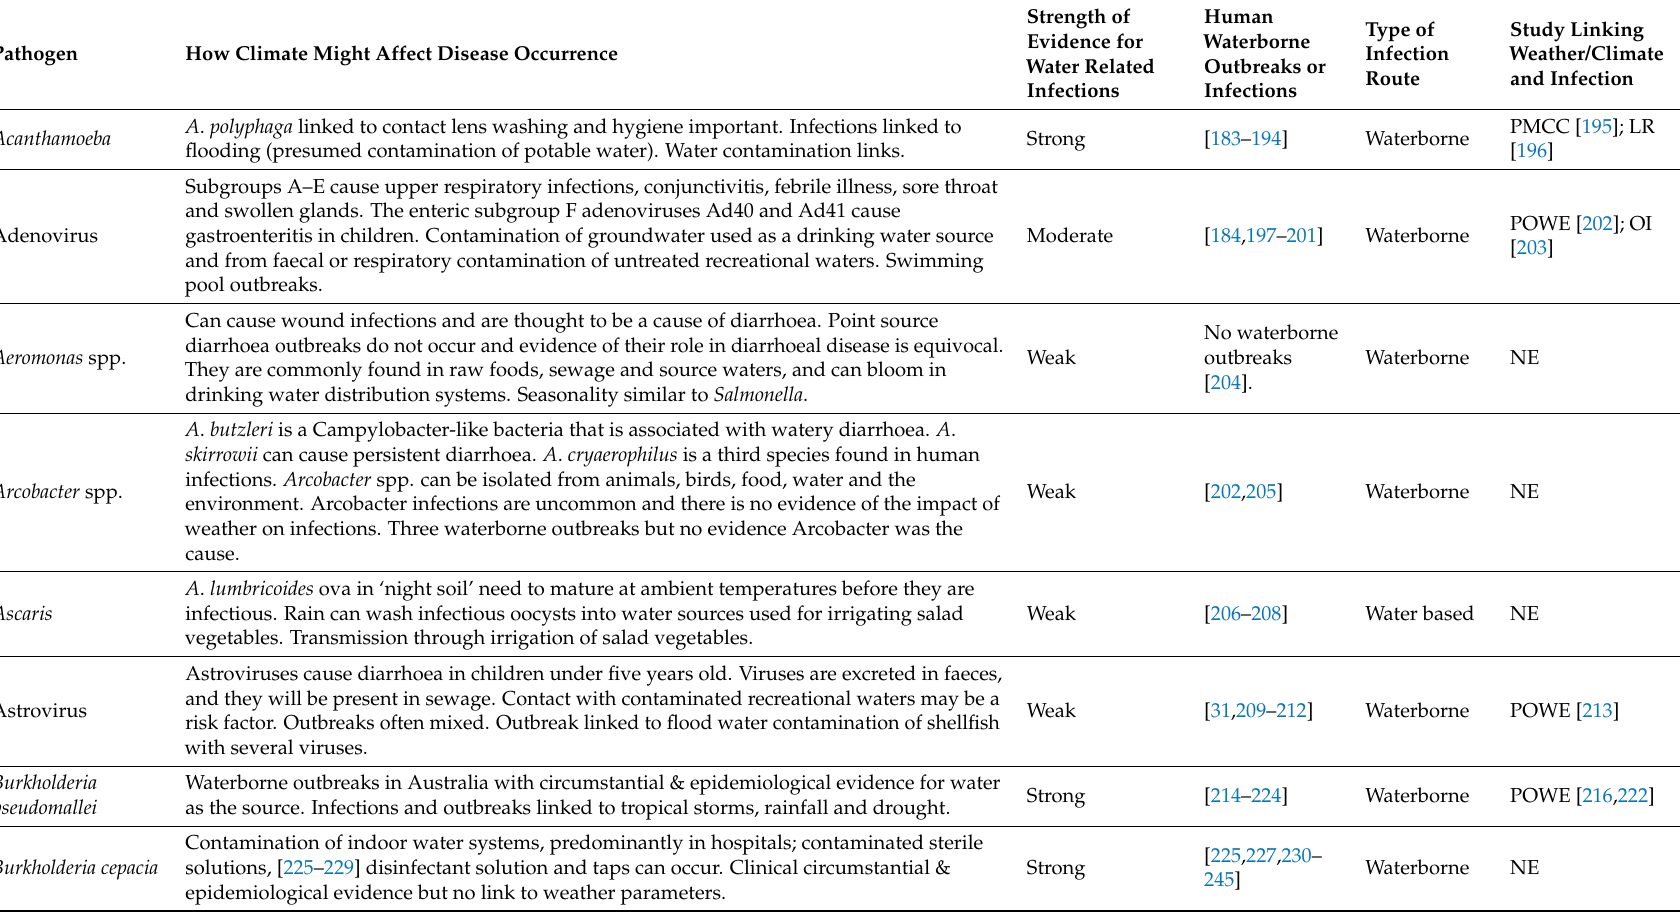
Table A1. Evidence of water related, waterborne, water-based, water contamination of equipment, water washed, water-based food contamination, water toxicosis, respiratory aerosol transmitted organisms, those that might be subject to climate change and the types of